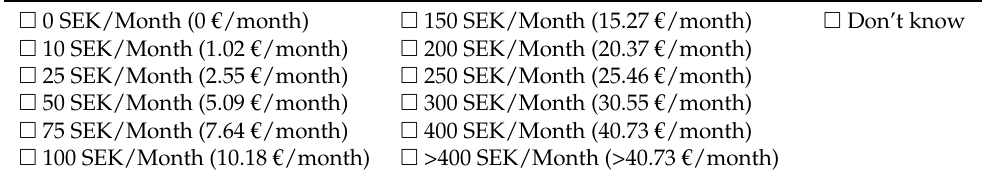
Table 1. Payment card used in the